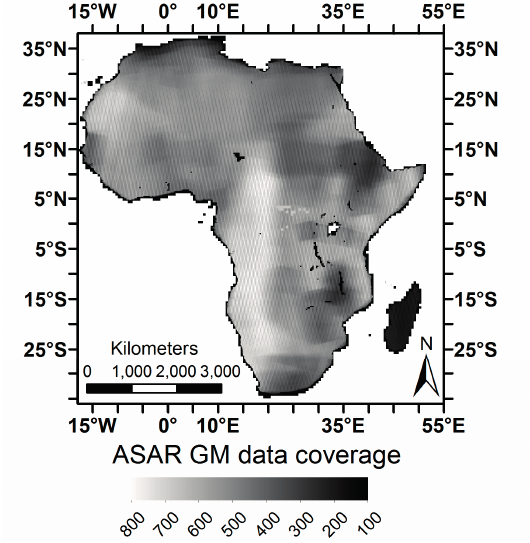
Figure 1. The number of Advanced Synthetic Aperture Radar Global Monitoring mode Surface Soil Moisture measurements between December 2004 and April